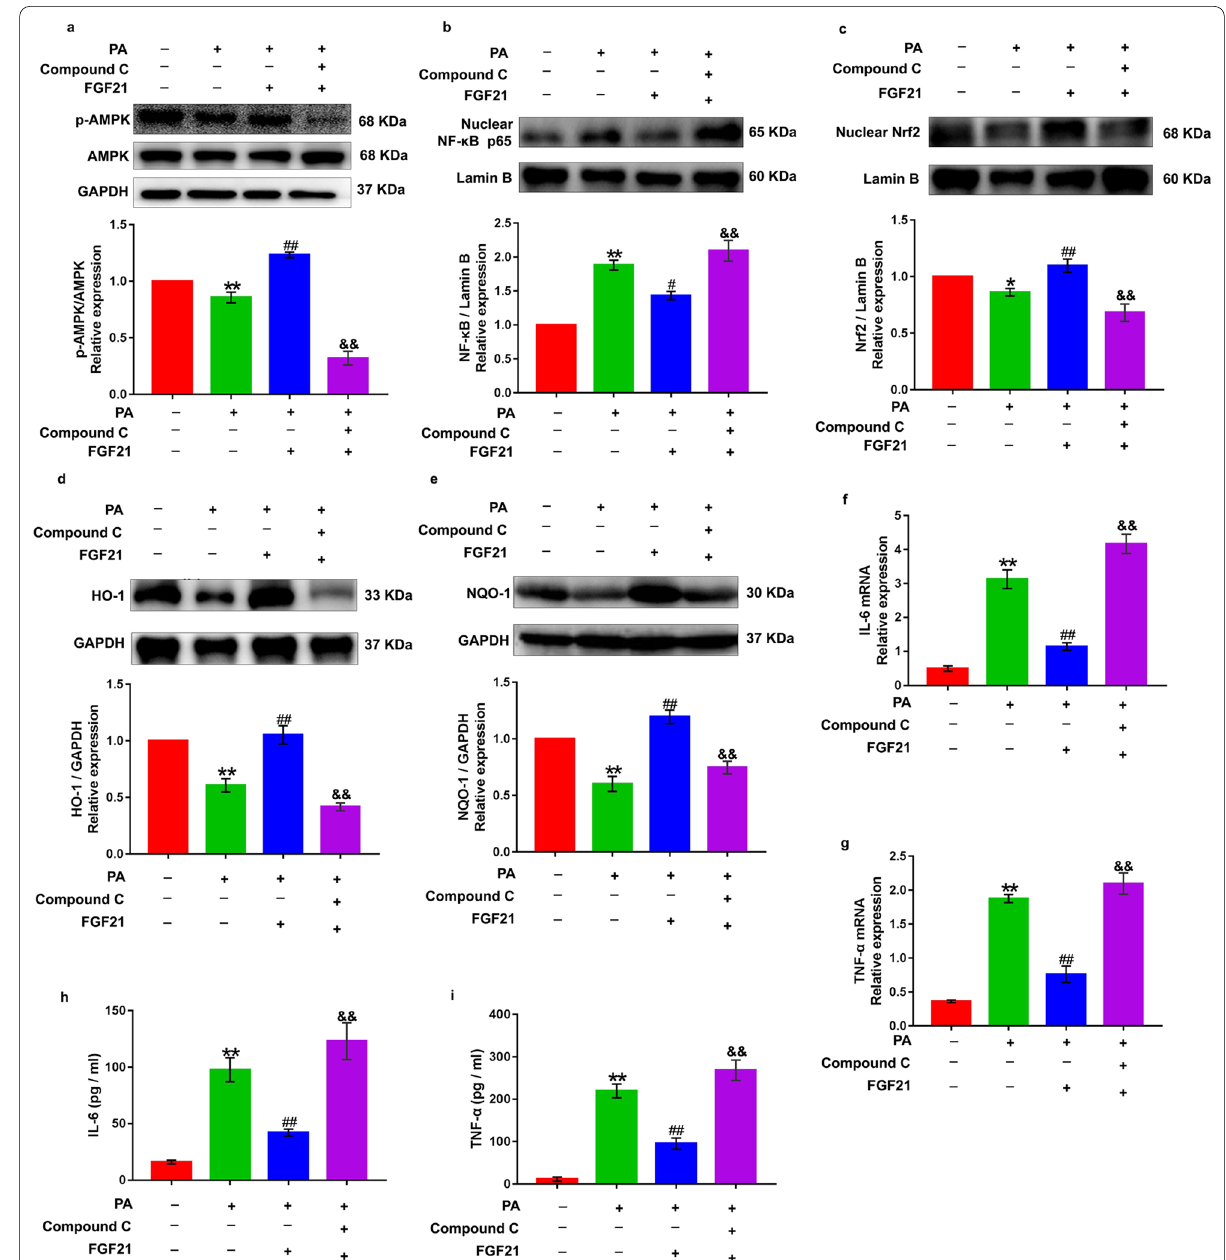
Fig. 7 AMPK inhibition blunted rhFGF21‑induced attenuation of inflammation and oxidative stress in PA‑treated HK‑2 cells. Phosphorylated AMPK was inhibited using Compound C (a ATP competitive AMPK inhibitor, 10 μM) in human renal tubular epithelial cells (HK‑2), the cells were then pretreated with rhFGF21 (50 ng/ml) for 2 h and subsequently stimulated with overdoes palmitate acid (PA, 1 mM) for 24 h. a Western blot analysis showed the effects of rhFGF21 and Compound C pretreatment on PA‑induced AMPK phosphorylation in HK‑2 cells. Image J was used to quantify the ratio of p‑AMPK/AMPK. GAPDH was used as the internal control. b and c The nuclear translocation levels of NF‑κB p65 and Nrf2 in nuclear fractions were detected by Western blot. Quantification of the nuclear protein expression of NF‑κB p65 and Nrf2 was analyzed by Image J. Lamin B was used as the internal control. d and e The expression of antioxidant associated proteins HO‑1 and NQO‑1 were measured by Western blot. Quantifications of proteins expression of HO‑1 and NQO‑1 were analyzed by Image J. GAPDH was used as loading and normalization control. f and g Quantitative RT‑PCR determination of IL‑6 and TNF‑α mRNA and values normalized to GAPDH. h and i ELISA analysis for the concentrations of IL‑6 and TNF‑α in HK‑2 cells supernatants. The values are expressed as the mean SD. *P < 0.05, **P < 0.01 versus the control group; # P < 0.05, ## P < 0.01 ± versus the PA group; & P < 0.05, && P < 0.01 versus the rhFGF21